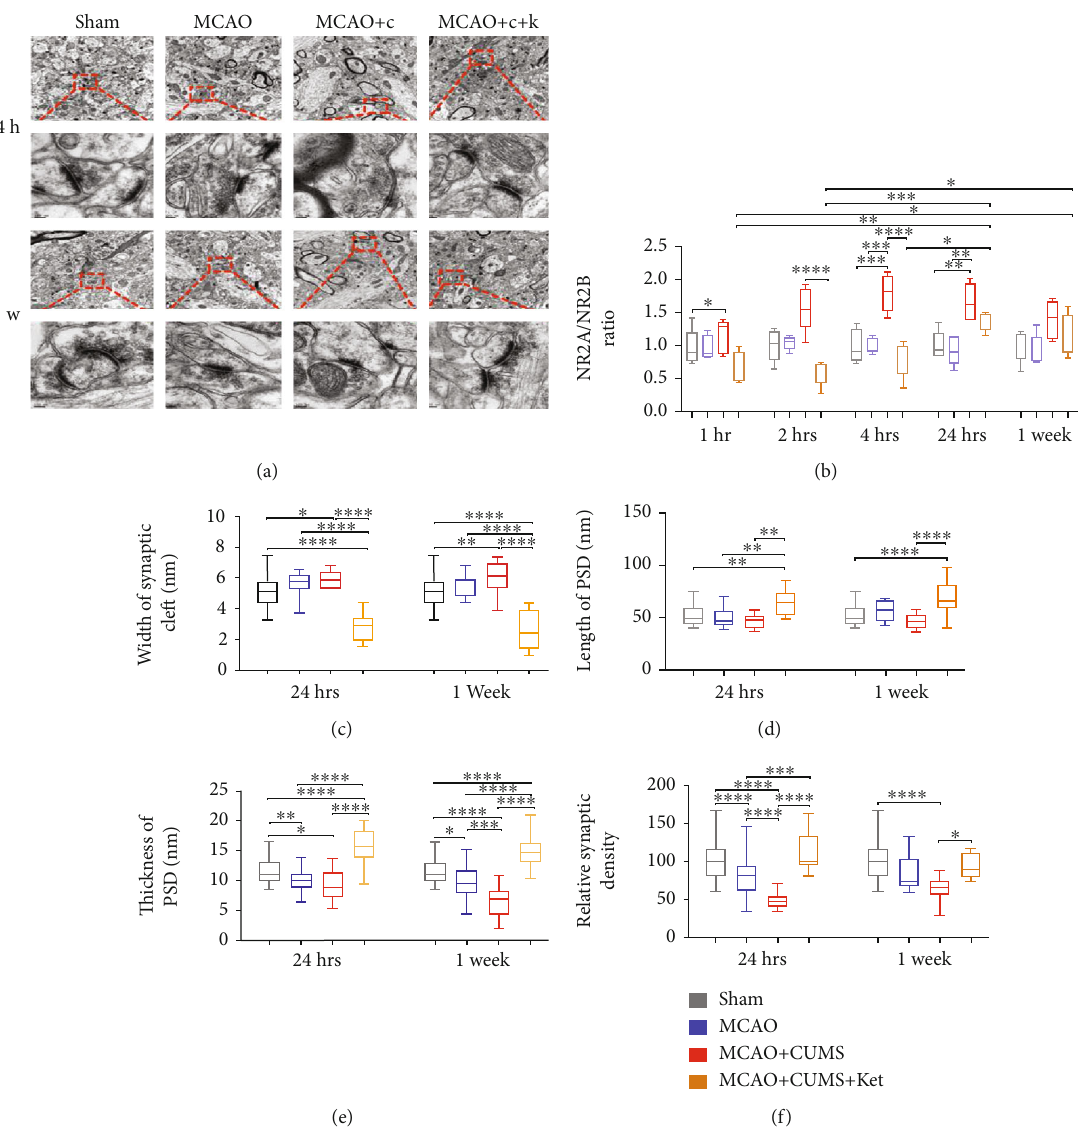
Figure 5: E ff ects of ketamine on synaptic plasticity in the hippocampal DG region of depressive-like MCAO rats. (a) Representative transmission electron microscopy images of synapses in the hippocampal DG region of various study groups at two di ff erent time points (10000x and 80000x) ( n = 3 rats). Scale bars: 1 μ m and 0.1 μ m, respectively. (b) The NR2A/NR2B ratio between di ff erent groups at di ff erent time points. (c) Comparison of the average width of synaptic cleft after ketamine administration. (d) Comparison of the average length of postsynaptic density between groups after treatment. (e) Comparison of the thickness of postsynaptic density between various groups one day and two weeks after treatment. (f) Comparison of the relative synaptic density between groups. 1hr: 1 hour, 2hrs: 2 hours, 4hrs: 4 hours, and 24hrs: 24 hours; PSD: postsynaptic density. One-way ANOVA followed by Tukey ’ s multiple comparison tests. n = 6 per group. ∗ p < 0 : 05 , ∗∗ p < 0 : 005 , ∗∗∗ p < 0 : 0005 , and ∗∗∗∗ p < 0 : 0001